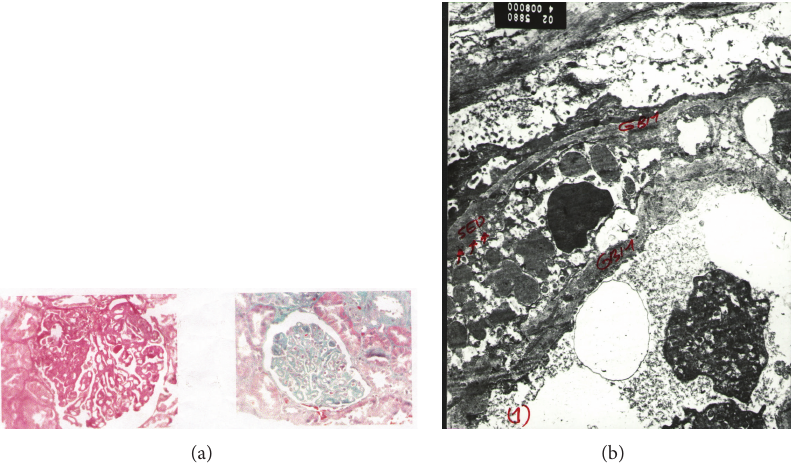
Figure 2: Renal histopathology. (a) Light microscopy. The tufts show marked diffuse thickening of the capillary basement membrane, sometimes amounting to wire-loop configuration. One tuft shows ischemic collapse and another shows a segmental area of proliferation with some nuclear dust. Tubules show focal foam cell transformation. H&E 400 x (left) & Masson trichrome 400 x (right). (b) Electron microscopy. There are electron dense deposits in the glomerular basement membrane (GBM) in the subendothelial region. Few mesangial and intramembranous deposits are seen as well, 8000 x.